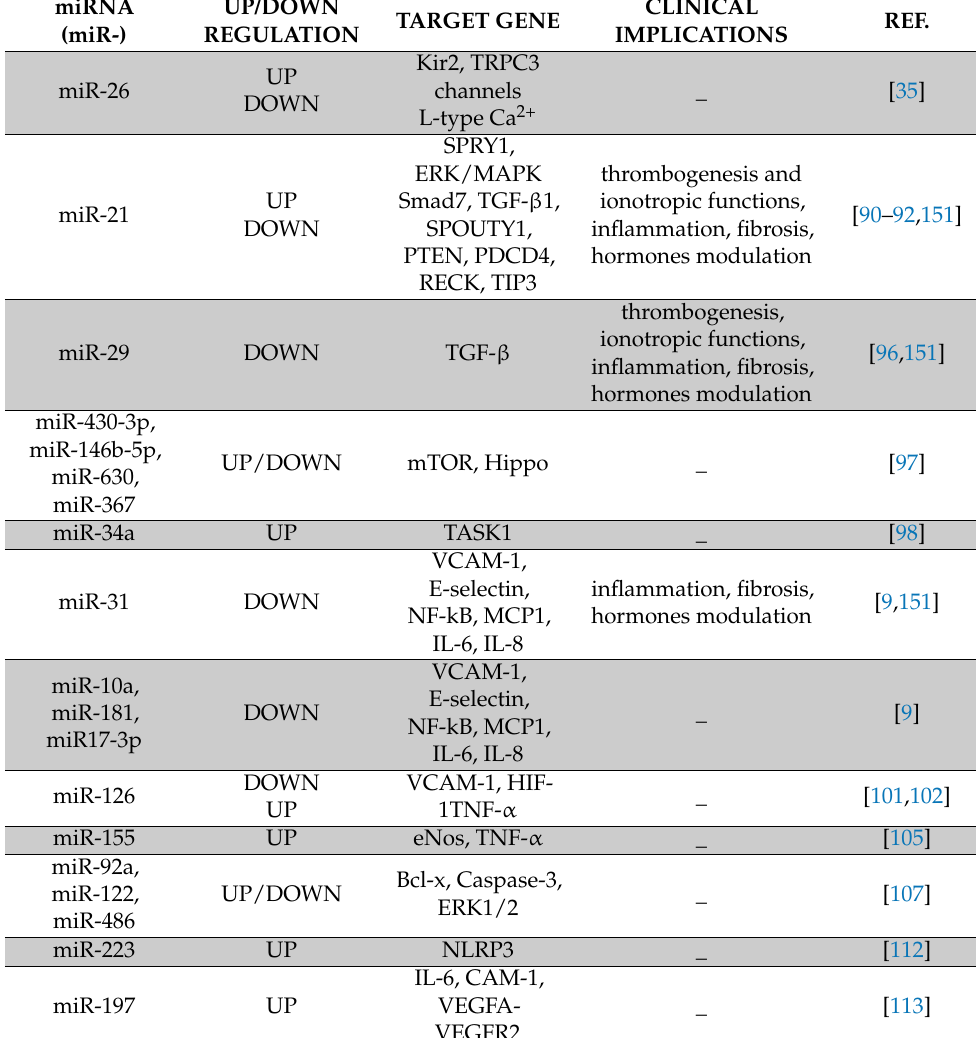
Table 1 recapitulates the studies showing the presence of specific miRNAs as biomark- ers in AF, their regulation, their gene target, and their clinical implications. Table 1. miRNAs as biomarkers in AF, their up and down regulation, their gene target, and their clinical implications. miRNA UP/DOWN CLINICAL TARGET GENE (miR-) REGULATION IMPLICATIONS